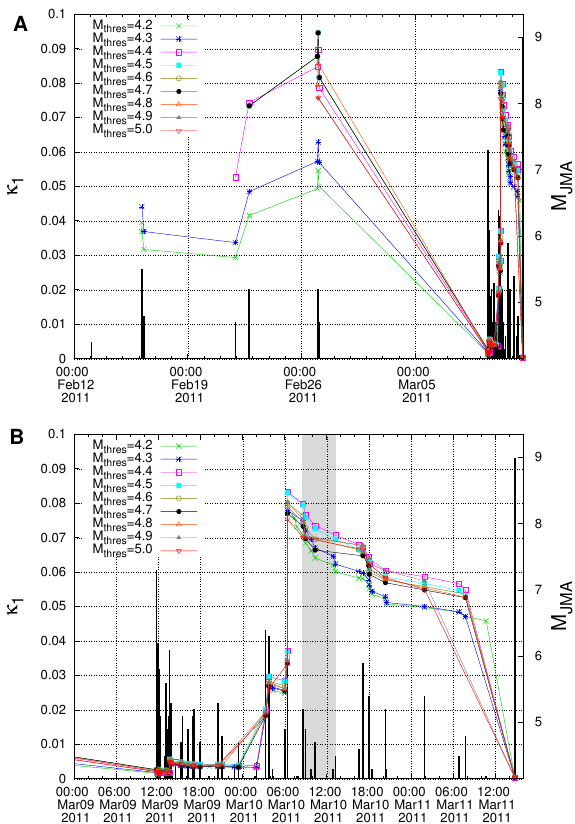
Figure 8. Determination of the occurrence time of M 9 Tohoku EQ. The evolution of the κ 1 values of seismicity (left scale) in the blue-green area of Figure 7 along with the EQs (right scale) shown with thick black vertical bars are plotted against the conventional time: ( A ) From 12 February 2011 until the M 9 Tohoku EQ occurrence on 11 March 2011. ( B ) From 00:00 LT on 9 March 2011 until the Tohoku EQ occurrence. The shaded area shows the period in the morning of 10 March 2011 during which the condition κ 1 = 0.070 is fulfilled (see the text). Taken from Ref.